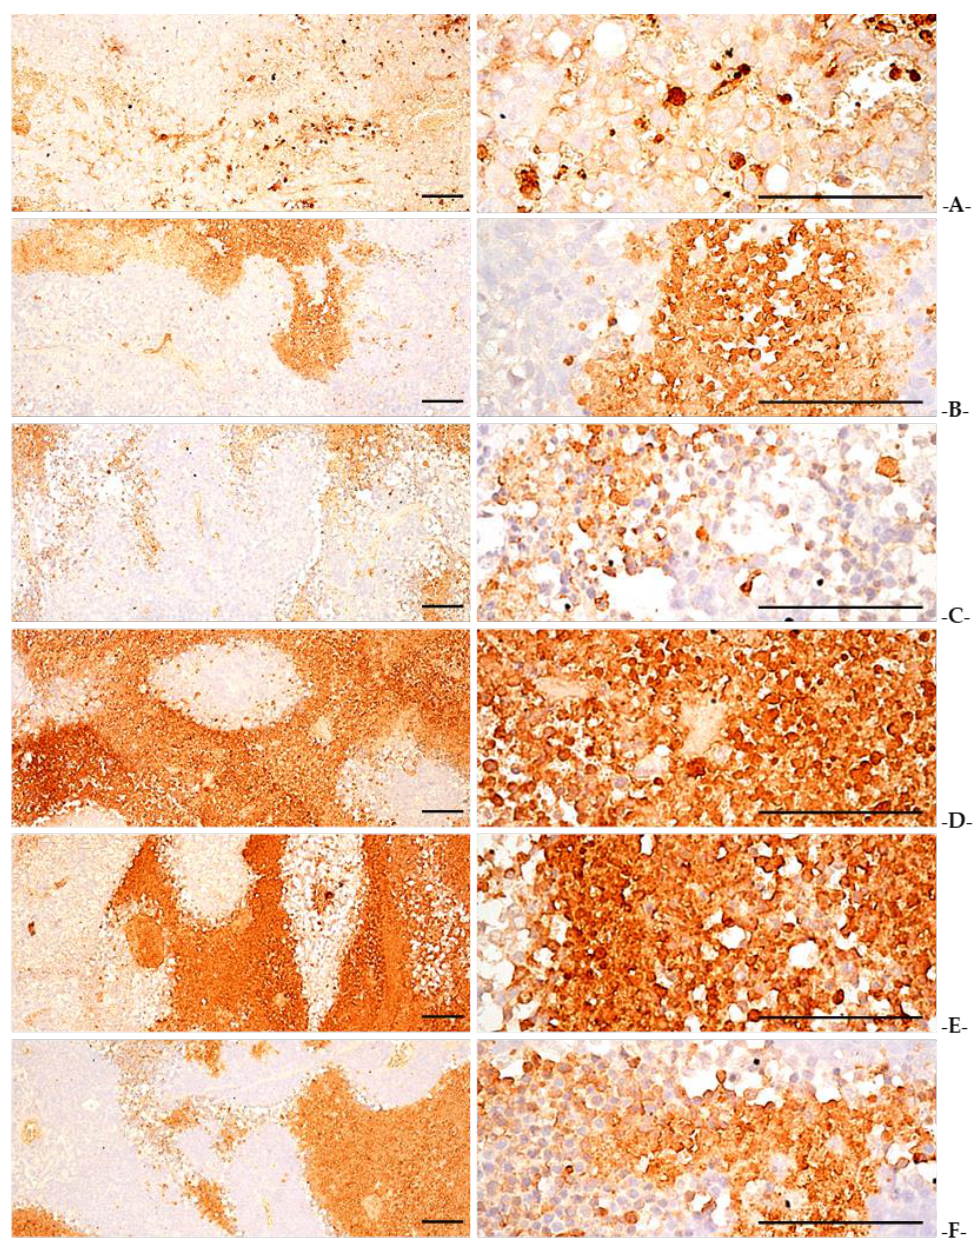
Figure 8. Representative caspase-3 immunoreactivities of the tumor masses taken from NCI-H520 tumor cell xenograft mice. ( A ) = Tumor-bearing control; ( B ) = 120 mg/kg-gefitinib-single-treated rodents; ( C ) = 400 mg/kg-SKOG-single-treated rodents; ( D ) = gefitinib 120 mg/kg and SKOG 400 mg/kg; ( E ) = gefitinib 120 mg/kg and SKOG 200 mg/kg; ( F ) = gefitinib 120 mg/kg and SKOG 100 mg/kg. AR = Adenophorae Radix; KOG = Kyeongokgo ; SKOG = sasam-Kyeongokgo . All avidin-biotin complex (ABC) methods. Scale bars = 100 μm.